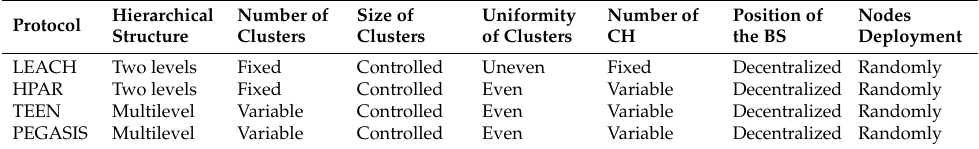
Table 2. Summary of the studied protocols based on